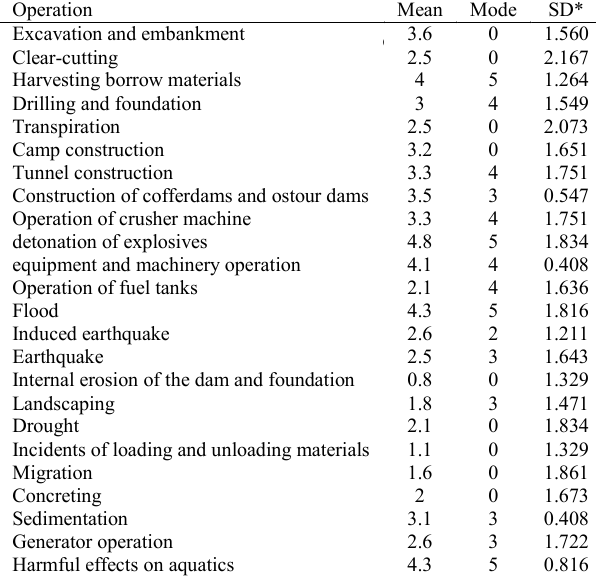
Table 10: Risks of Gavi Dam at constructional phase